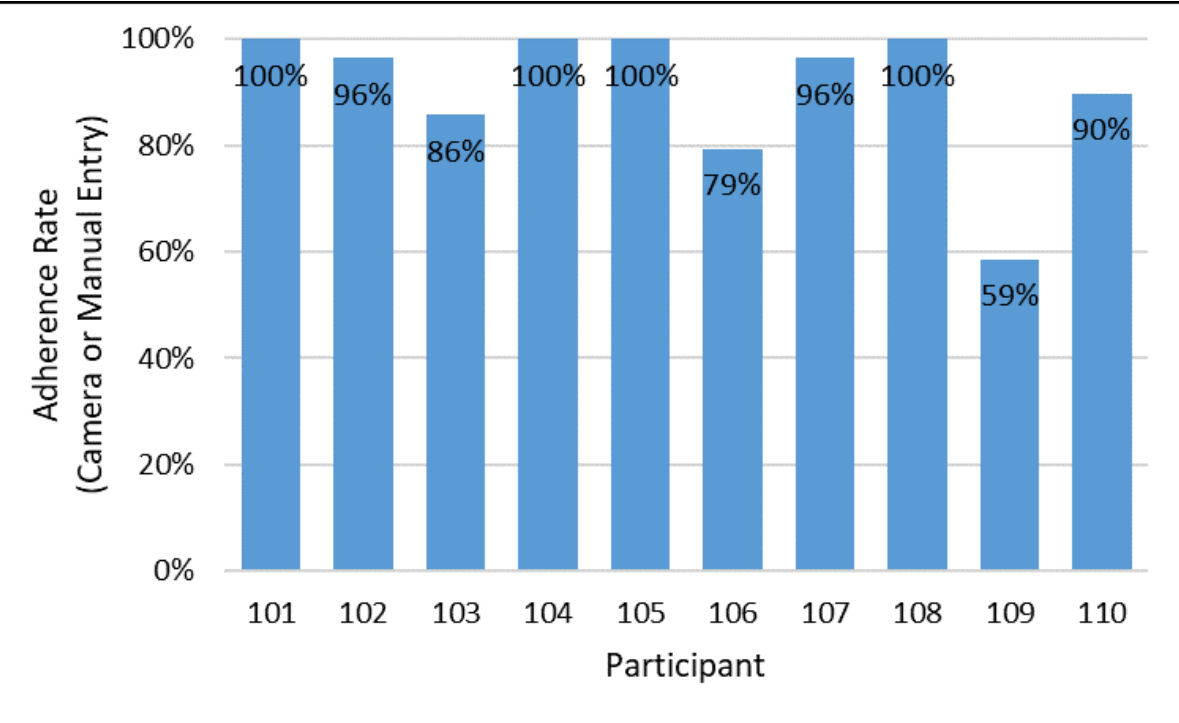
Figure 3. Percentage of time the individual participants logged a dose in mSMART using either the camera-based medication event-monitoring tool or manual entry